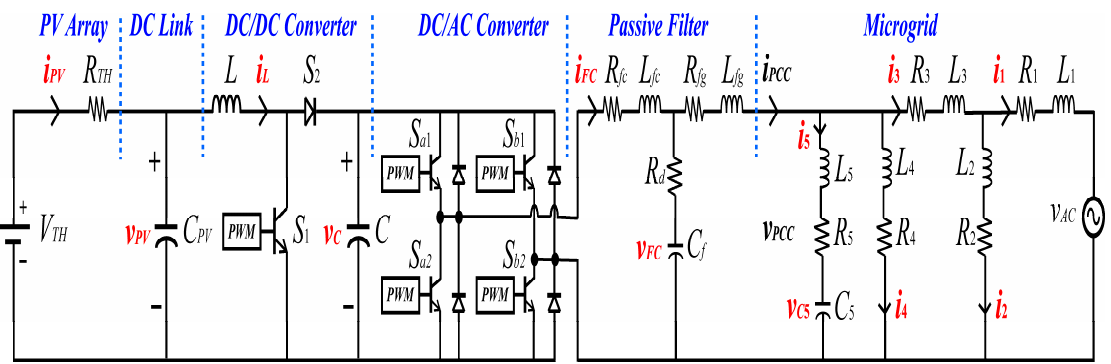
Table 1. Data of grid-connected PV generation system. PV Array at STC N S